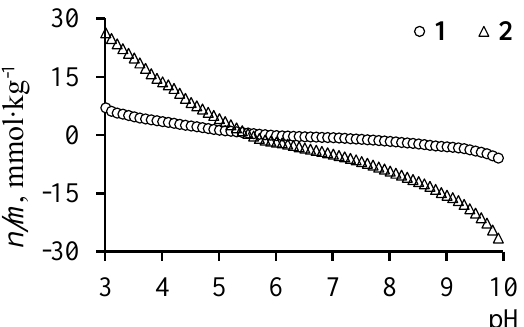
Figure 3. Smoothed averaged titration curves of water extract ( 1 ) and scour waters ( 2 ); the O horizon of Distric Albic Retisol (Loamic).